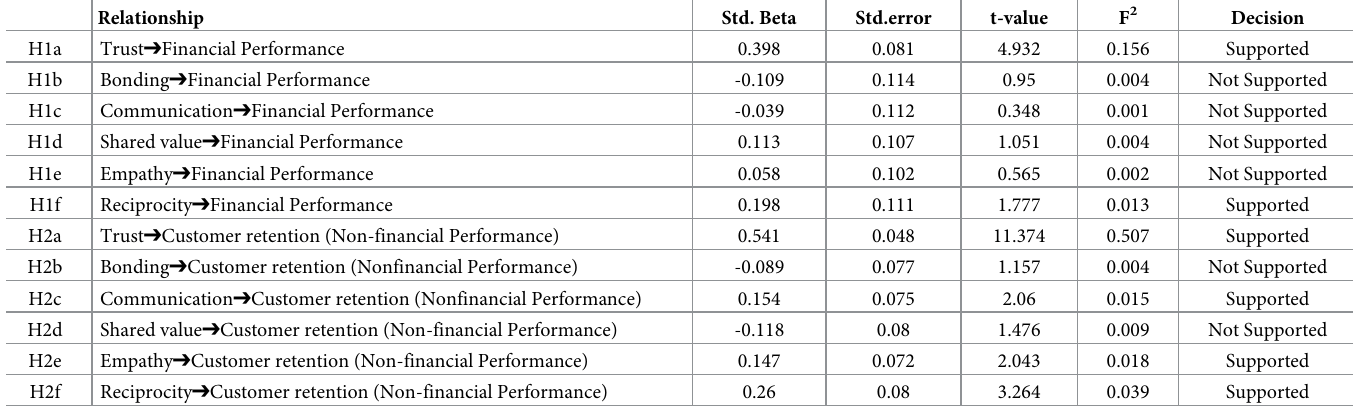
Table 4. Hypotheses